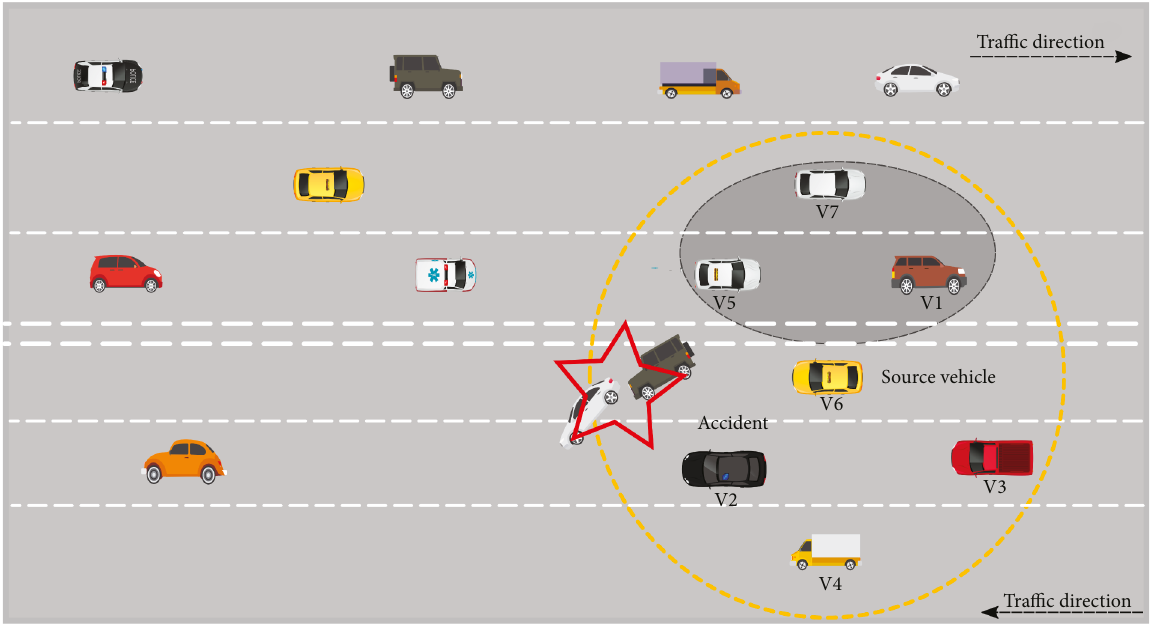
Figure 4: Information dissemination to vehicles in the interest zone only.